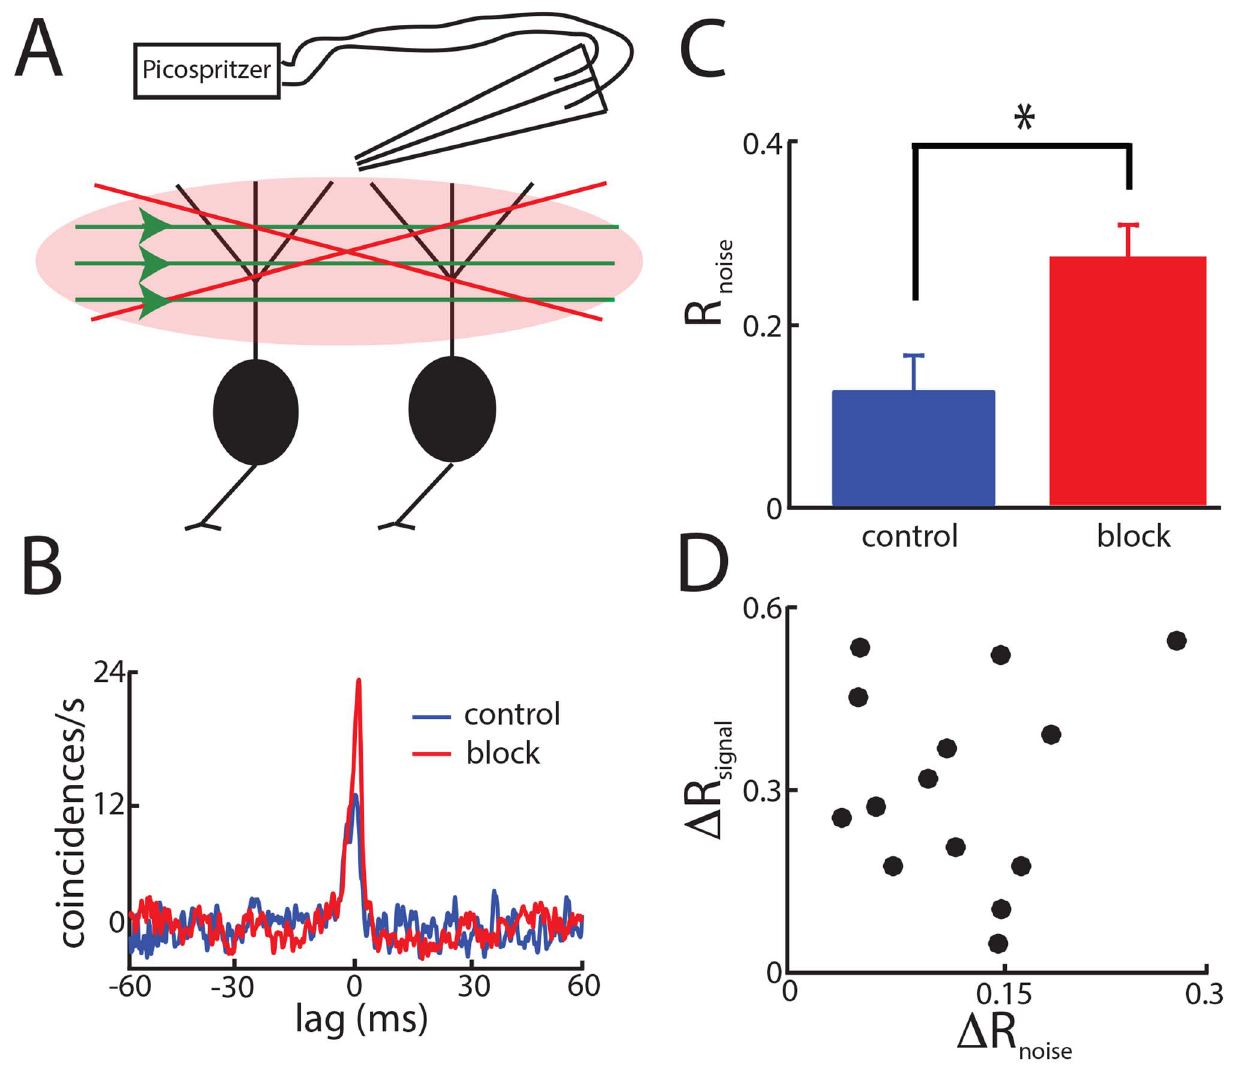
Fig. 7. Pharmacological inactivation of indirect feedback input onto ELL pyramidal cells increases noise correlations. A ) Schematic of the pharmacological inactivation technique. B ) Noise CCG from an example pair of same type ELL pyramidal cells under 4 Hz global stimulation before (control, blue) and after (block, red) pharmacological inactivation of feedback pathways. C ) Population-averaged noise correlation coefficients under control (blue) and during the block (red). ‘‘*’’ indicates statistical significance at the p=0.05 level using a signrank test with N=14. D ) Change in signal correlation coefficient (block-control) as a function of the change in noise correlation coefficient (block-control). No significant correlation was observed between both quantities (R=0.32, p=0.18, N=14).